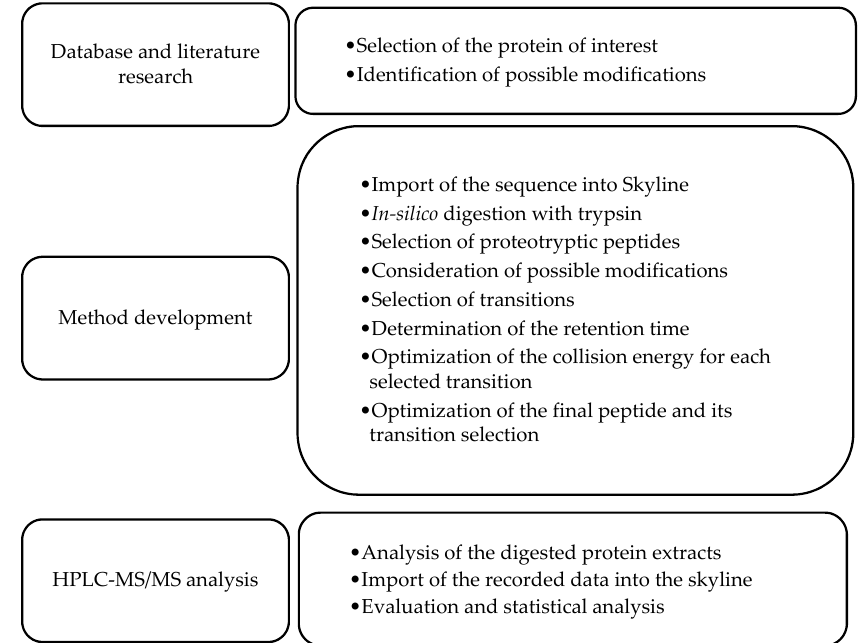
Figure 1. Method development for the relative quantification of the peptides by LC-MS/MS.